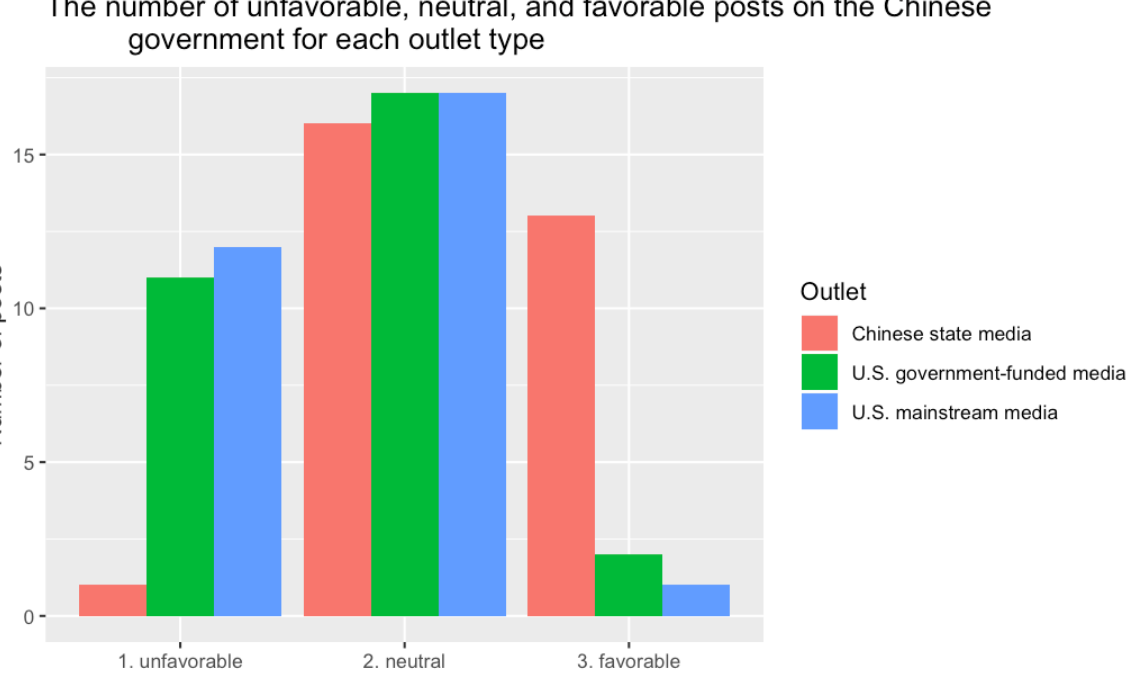
Figure 3 : The number of posts including an unfavorable, neutral, and favorable framing of the Chinese government response for each of the three outlets across 90 randomly selected posts (30 for each outlet) mentioning the Chinese government. Chinese state media include a significantly higher share of favorable posts, but only one (3%) unfavorable one, whereas 12 posts in U.S. mainstream media (40%)